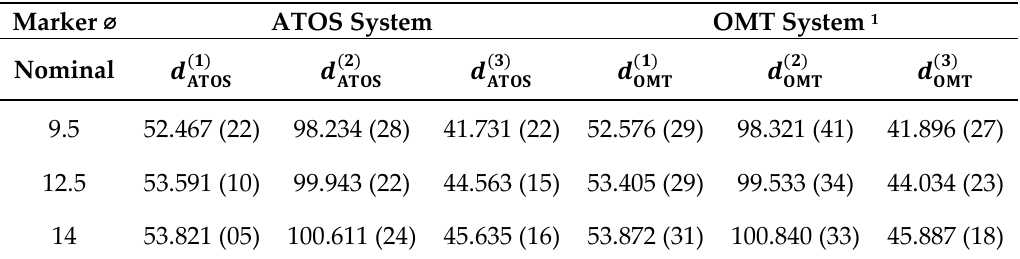
Table 1. Repeated measures of OMT marker distances on the rigid body in resting position by ATOS and Vicon. All values presented as Mean in mm (SD in